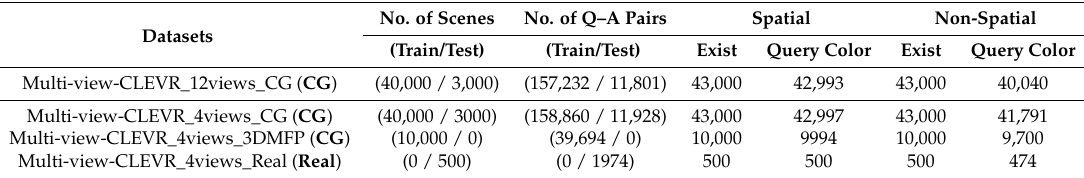
Figure 4. Virtual camera setup (left) and example images and questions from Multi-view- CLEVR_12views_ CG dataset (right). The default view determines the spatial relationships of objects in each scene. Table 1. Statistics for datasets used in this study.